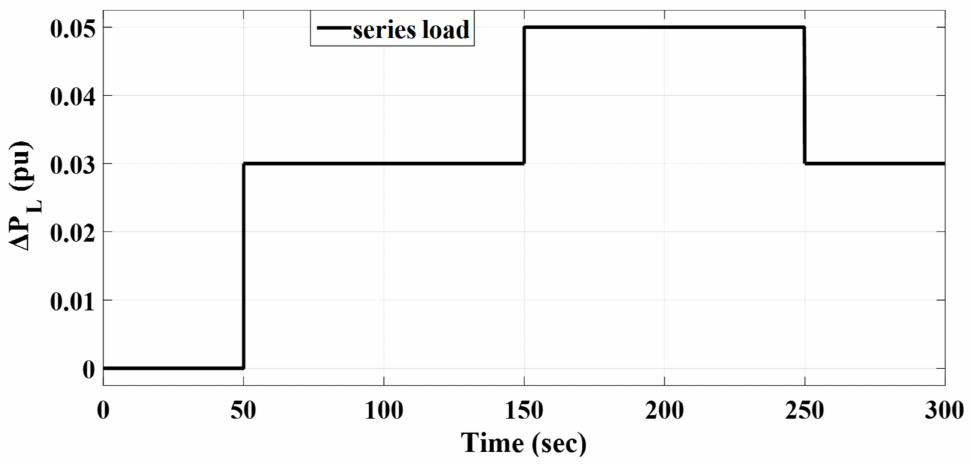
Figure 17. The form of the applied series step load perturbation.